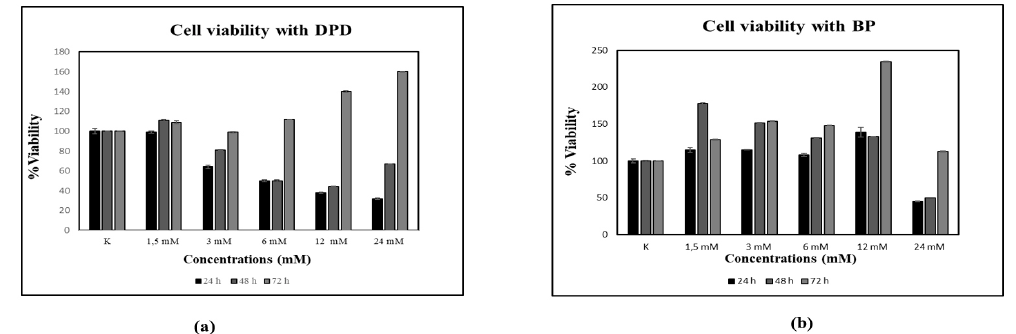
Figure 1. Effects of DPD ( a ) and BP ( b ) on cell viability. The results are expressed as mean ± SD.